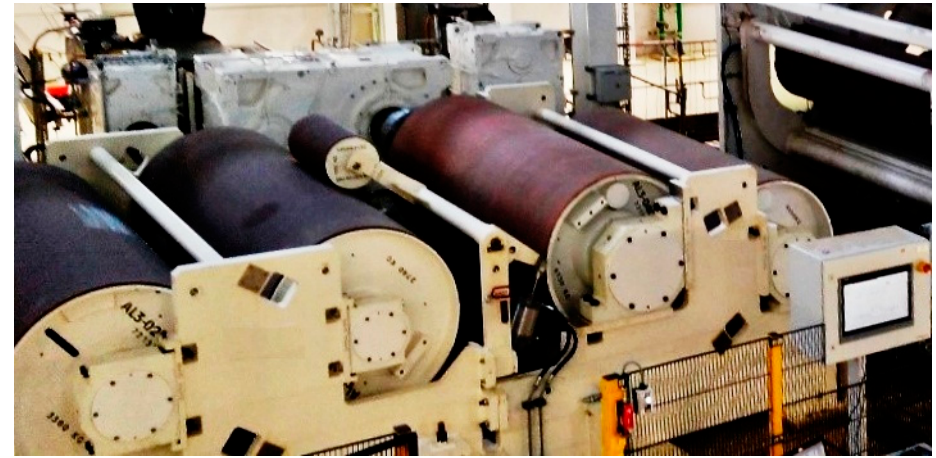
Figure 7. Tension leveler on a realistic production line where experimental results were